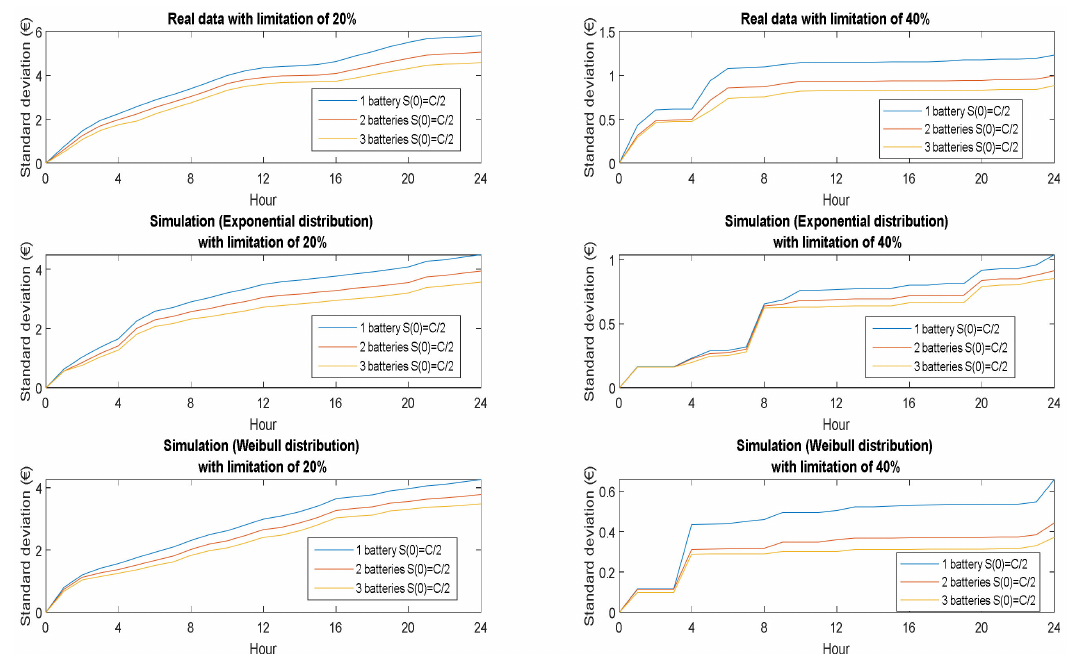
Figure 13. Standard deviation for real and theoretical data for the percentage limitations of 20% (first row) and 40% (second